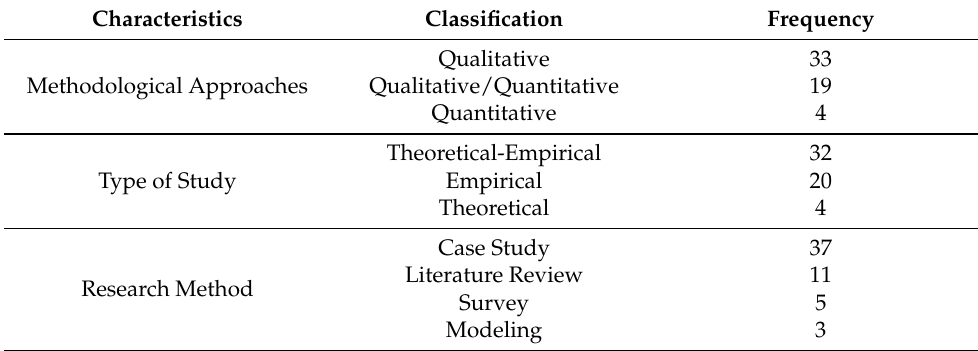
Table 1. Studies characteristics. Characteristics Classification Methodological